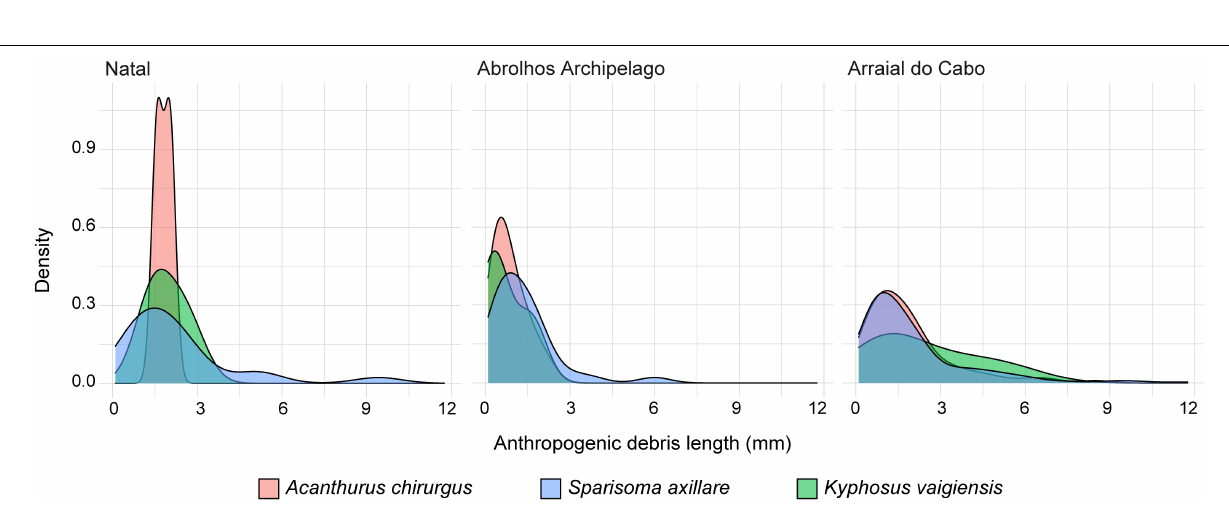
FIGURE 2 | Density plot of the length of the anthropogenic debris found in the species’ gut contents sampled at each location.